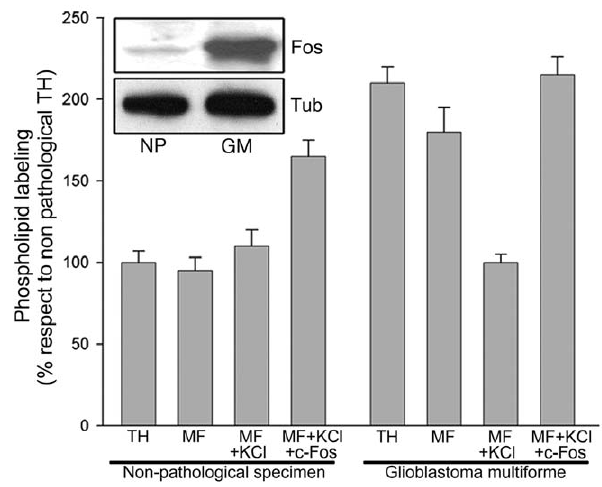
Figure 2. Phospholipid synthesis is activated in c-Fos-contain- ing membranes from a human GM. A human GM and adjacent non pathological tissue excised from the same patient were used to prepare total homogenate (TH), microsomal membrane fraction (MF), 1M KCl- stripped microsomal membrane fraction (MF + KCl) and stripped MF plus 1 ng of c-Fos/ m g of TH (MF + KCl + c-Fos) and assayed for phospholipid synthesis capacity. Results are the mean % 6 SD of 3 experiments performed in triplicate; non-pathological TH values were taken as 100%. Inset: WB for c-Fos content in the samples assayed; Tubulin staining is used as a loading control. NP: non-pathological; GM: glioblastoma multiforme.